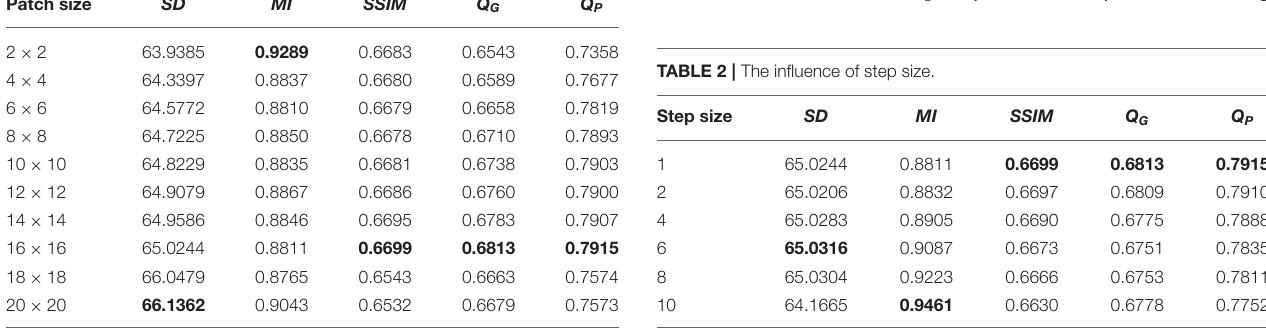
Frontiers in Neurorobotics |